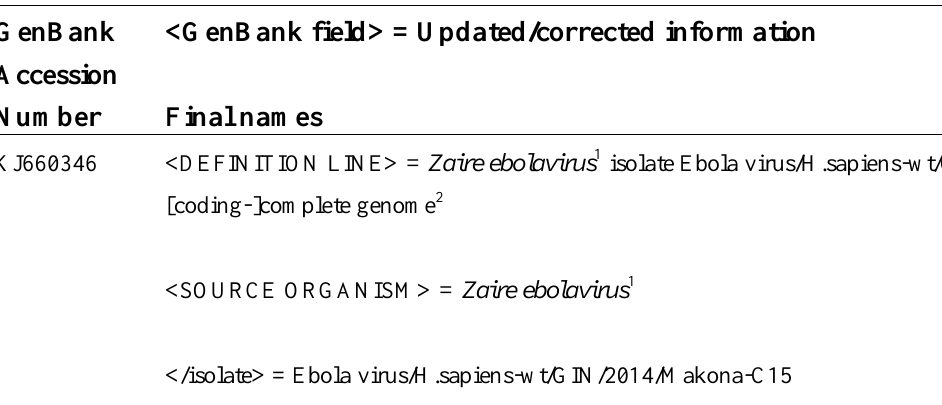
Table 3. EBOV isolates from the West African EVD outbreak, 2014: Updated and/or corrected GenBank fields and final